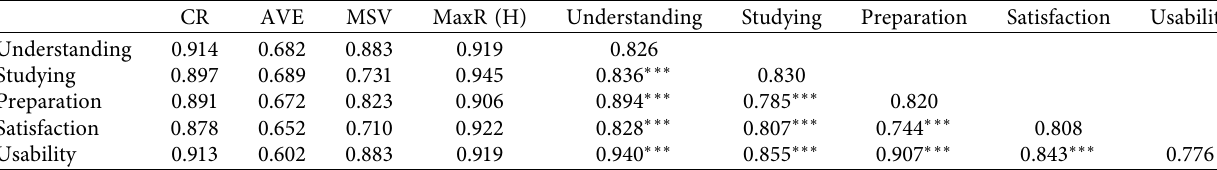
Table 5: Reliability and validity indices of model 2.